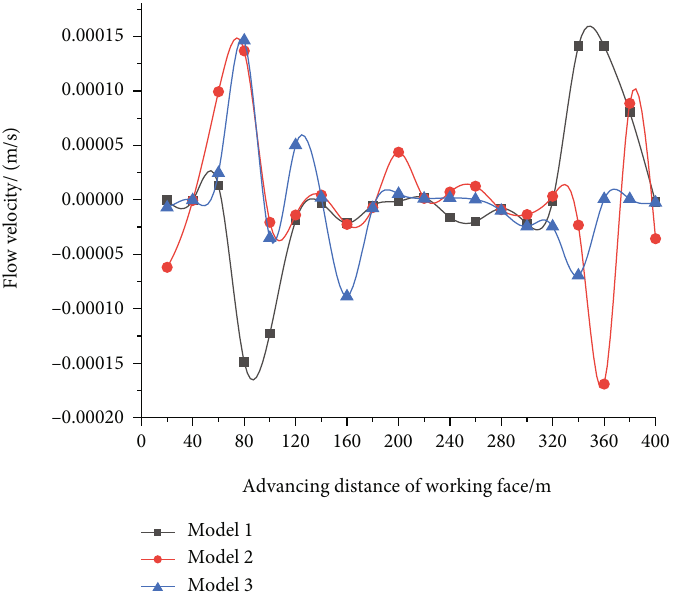
Figure 12: Variation law of roof water velocity of each